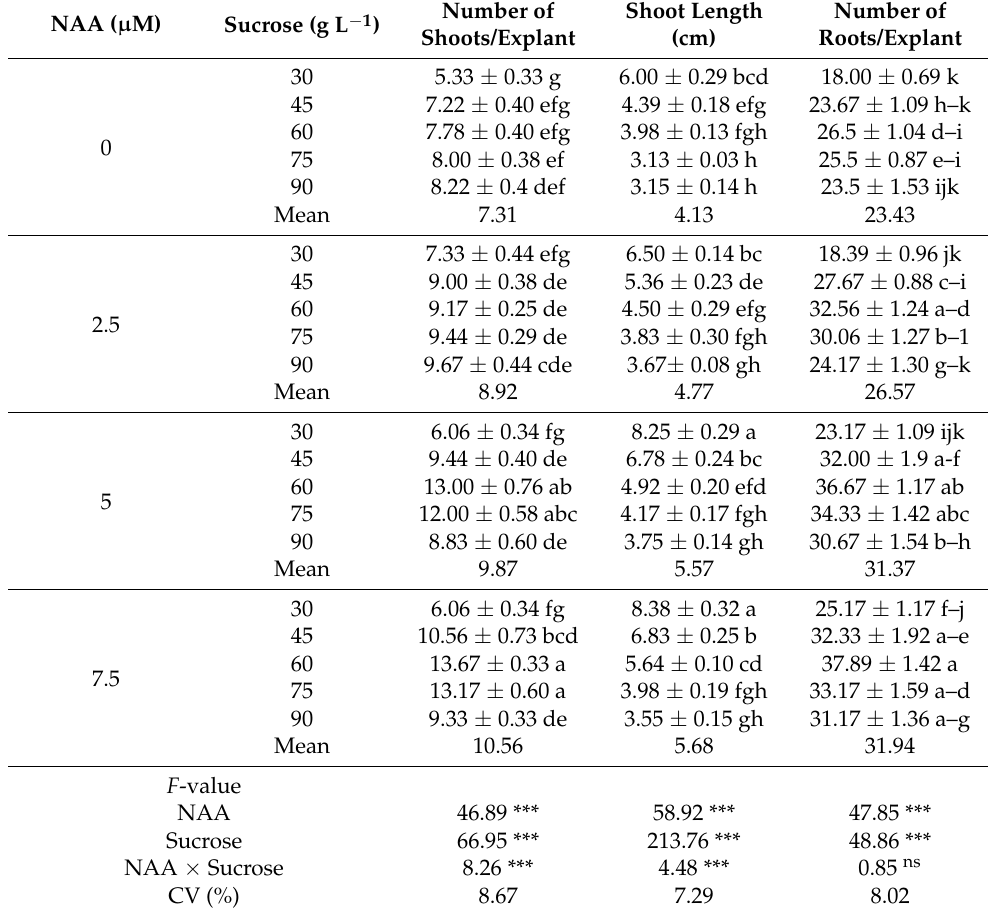
Table 4. Effects of different sucrose and NAA concentrations on shoot multiplication and rooting of Bentong ginger after 12 weeks of